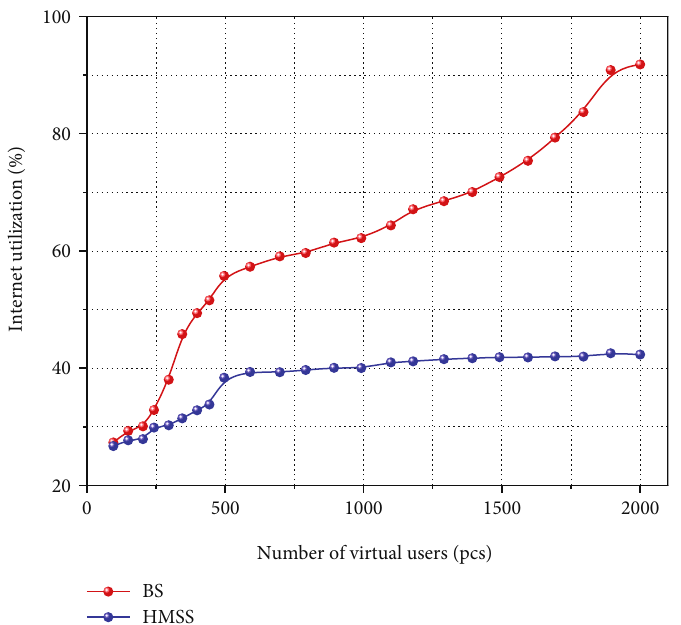
Figure 5: Comparison of network bandwidth utilization between HMSS and benchmark authentication mode.